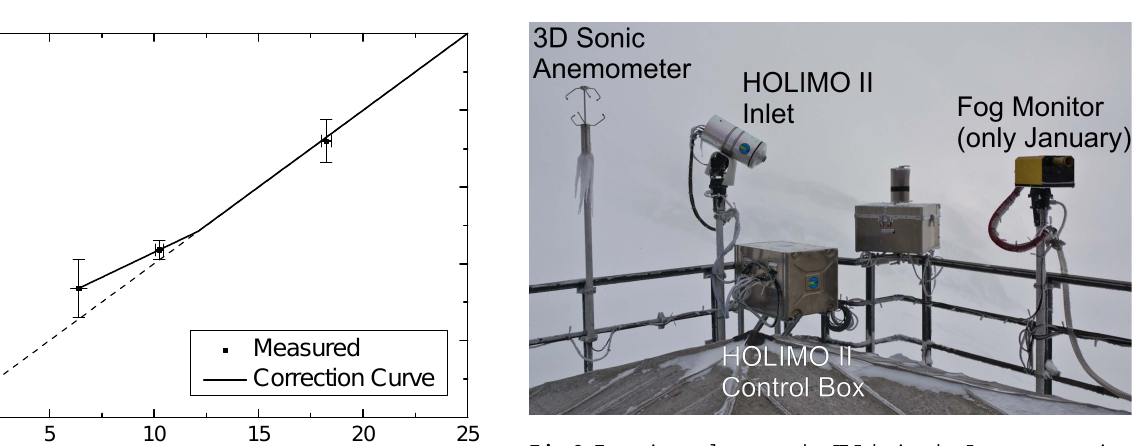
Fig. 6. Experimental setup at the JFJ during the January campaign. The picture faces southeast. Instruments were mounted on posts fastened to the railing on the upper terrace of the Sphinx labo- ratory. The unlabeled box (second from right) is from a different